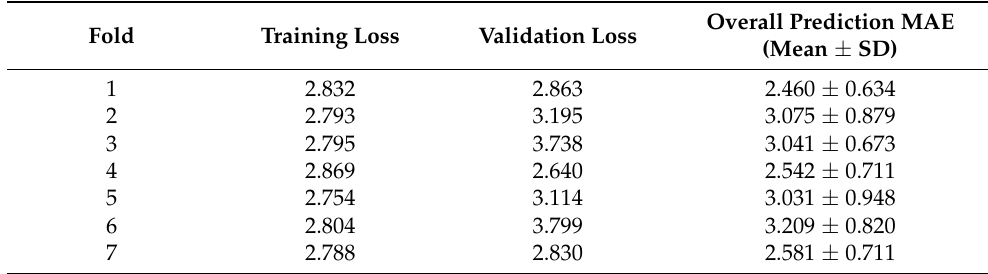
Table 4. Training and validation losses in the last epoch in the seven-fold cross validation method, along with the overall prediction MAE.